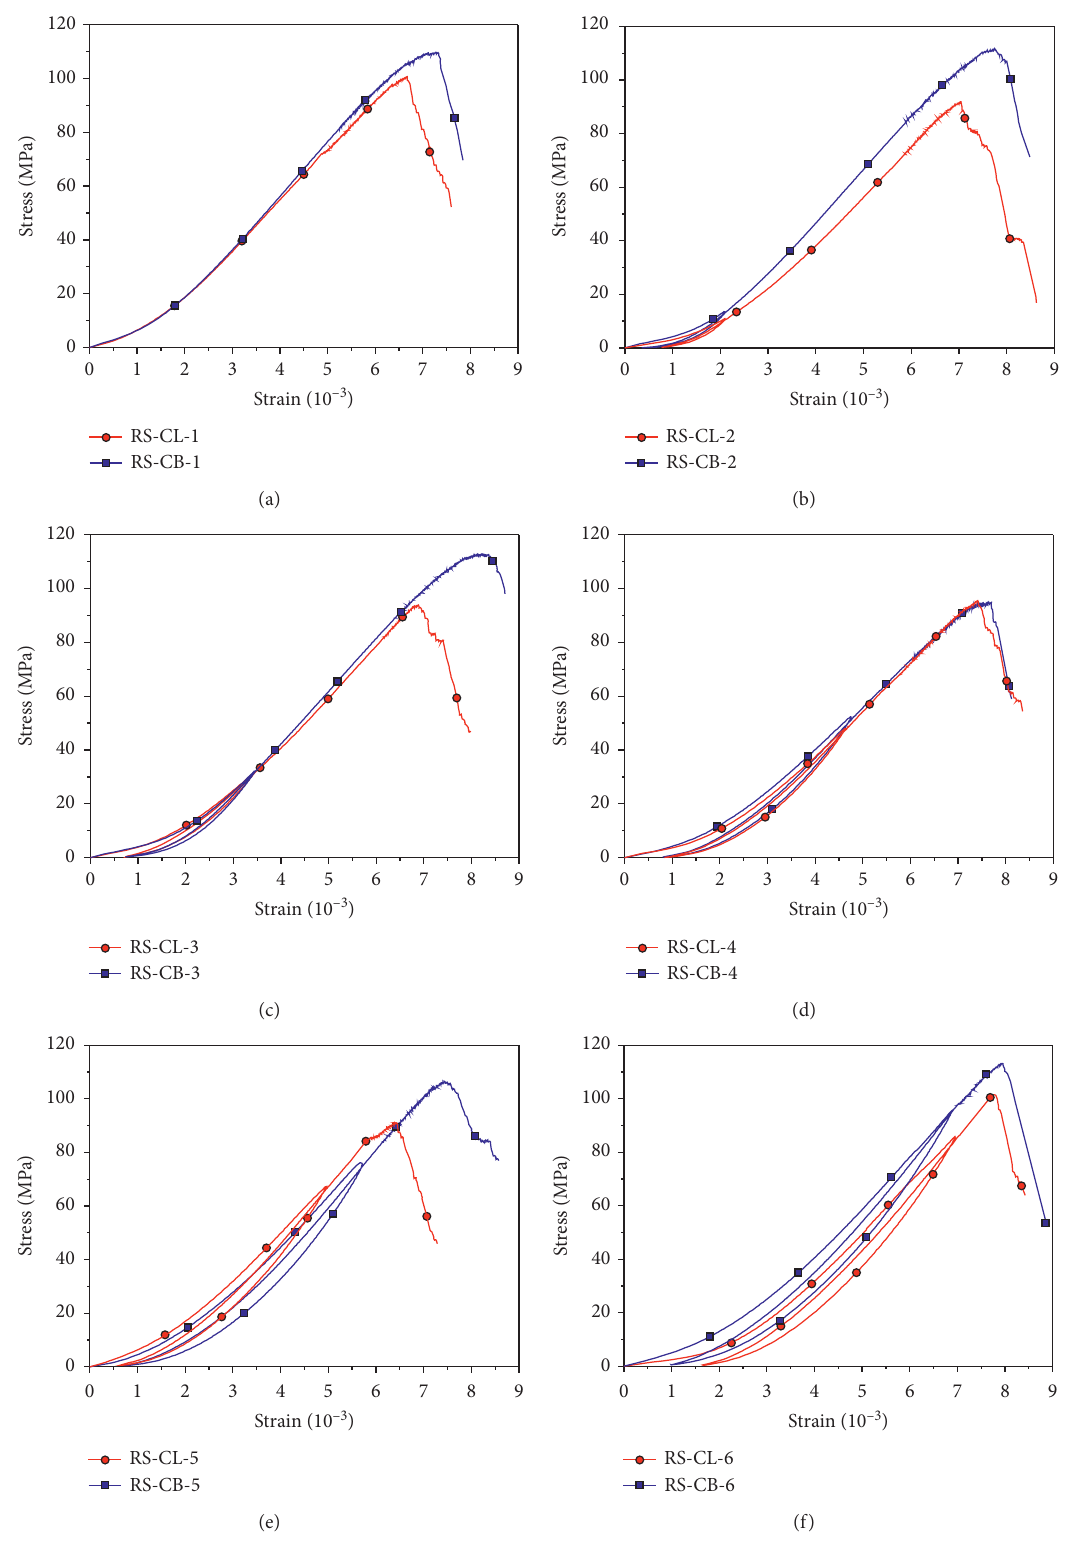
Figure 3: Stress-strain curves of cylindrical and cuboid specimens. (a) UC test. (b) i � 0.1. (c) i � 0.3. (d) i � 0.5. (e) i � 0.7. (f) i �